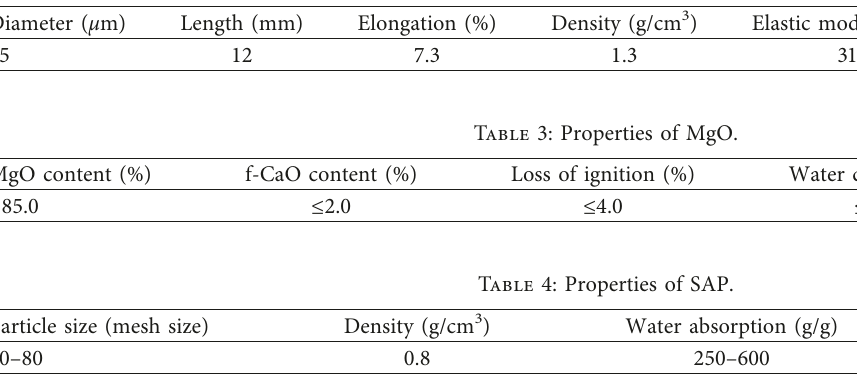
Table 2: Physical and mechanical properties of the PAV fiber.